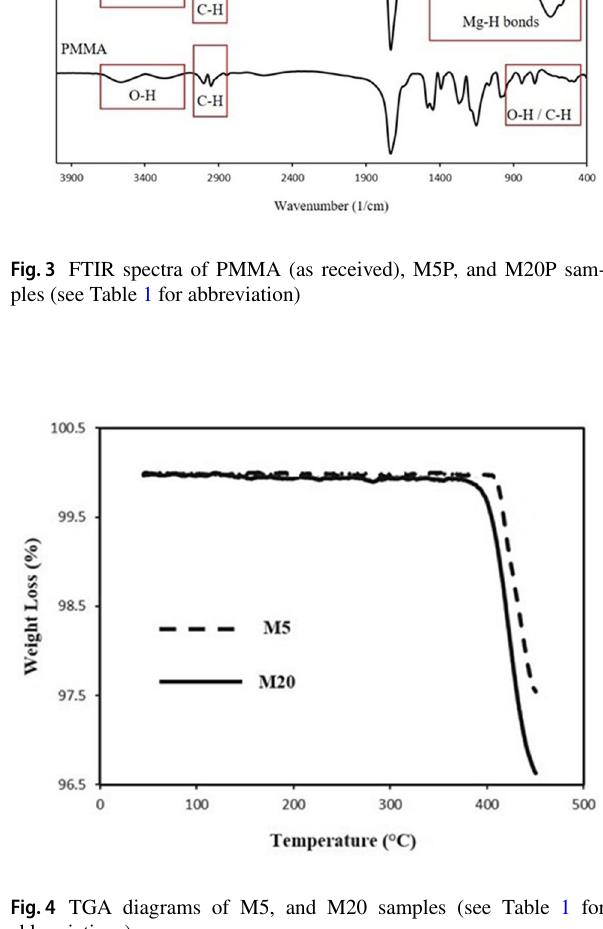
Fig. 4 TGA diagrams of M5, and M20 samples (see Table 1 for abbreviations)